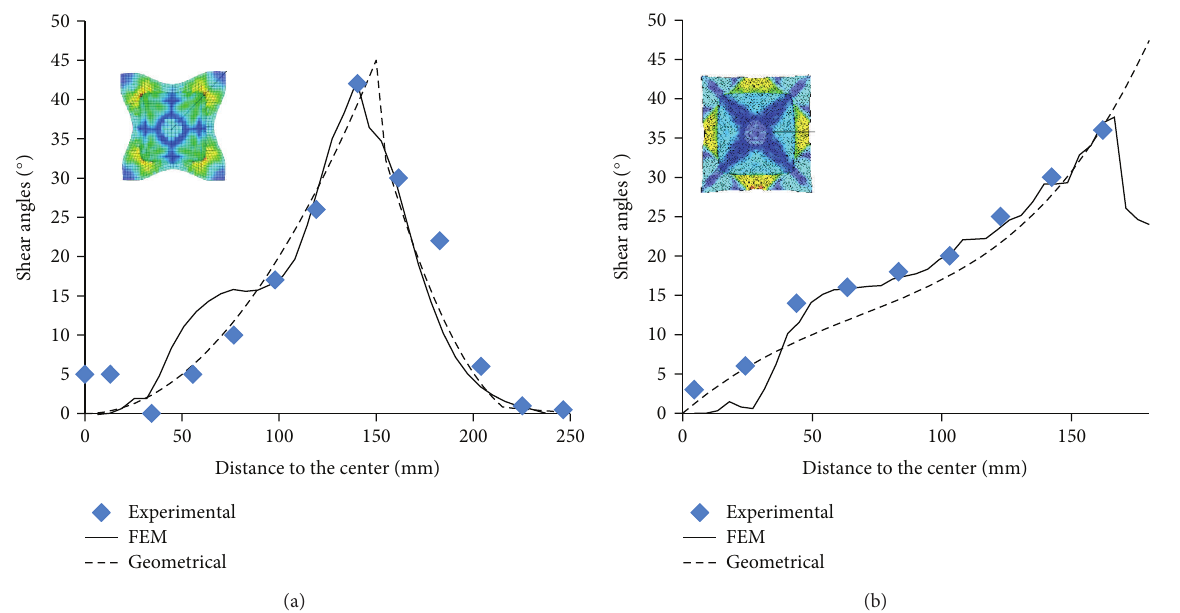
F 19: Shear angles: (a) along the diagonal line of 0 and (b) along the symmetrical line of 45